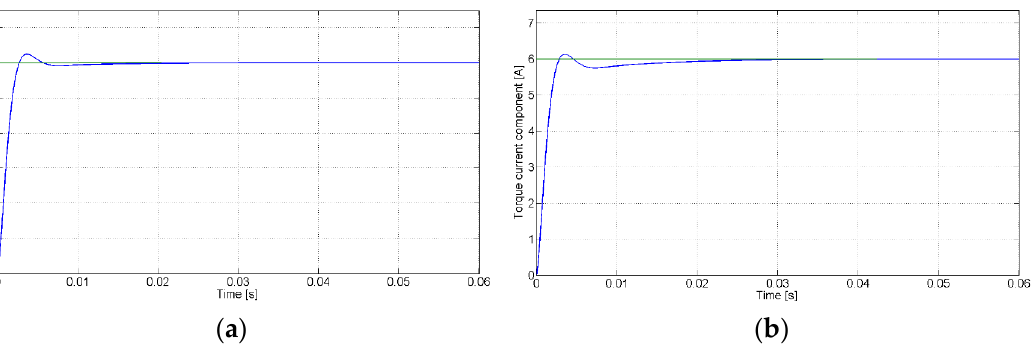
Figure 9. Simulation results: reference (green) and actual (blue) torque-producing stator current with decoupling; ( a ) total moment of inertia J t = 0.043 kgm 2 (including DC machine), steady-state value of torque-producing stator current is 6 A; ( b ) total moment of inertia J t = J M = 0.013 kgm 2 (induction motor only), steady-state value of torque-producing stator current is 6 A.